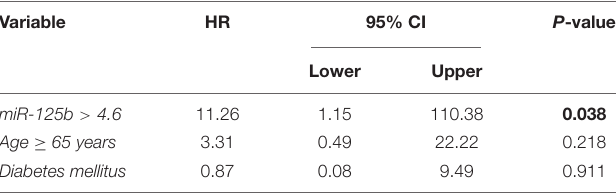
TABLE 4 | Multivariate Cox regression model for prediction of long-term all-cause